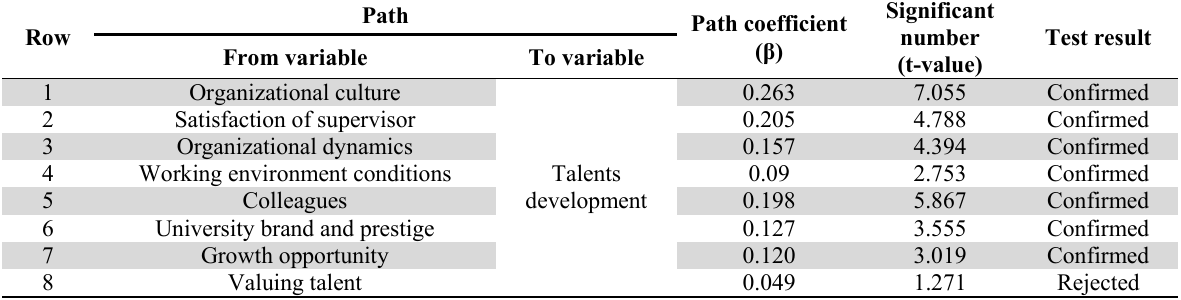
Results of the structural model evaluation for the first